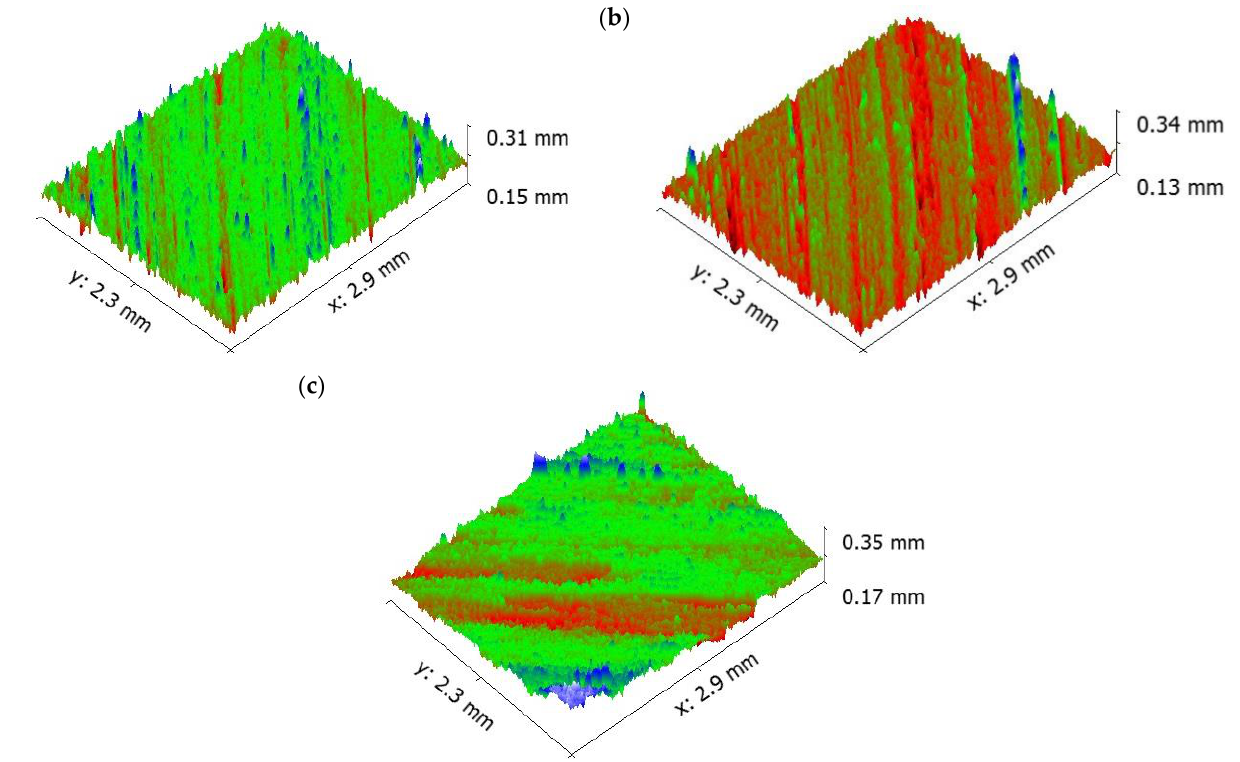
Figure 13. Temperature of the pin at 50 N loads at 5 min: ( a ) 5 wt.% and ( b ) 10 wt.%.